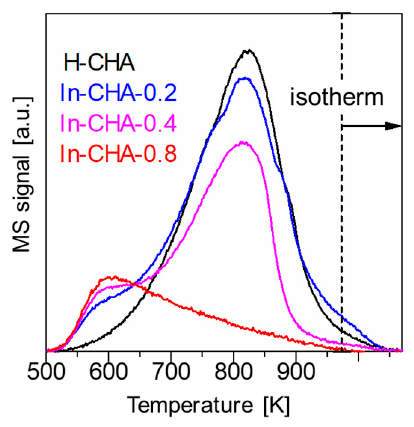
Figure 3. Ammonia temperature-programmed desorption (NH 3 -TPD) profiles for H-CHA and di ff erent In-CHA